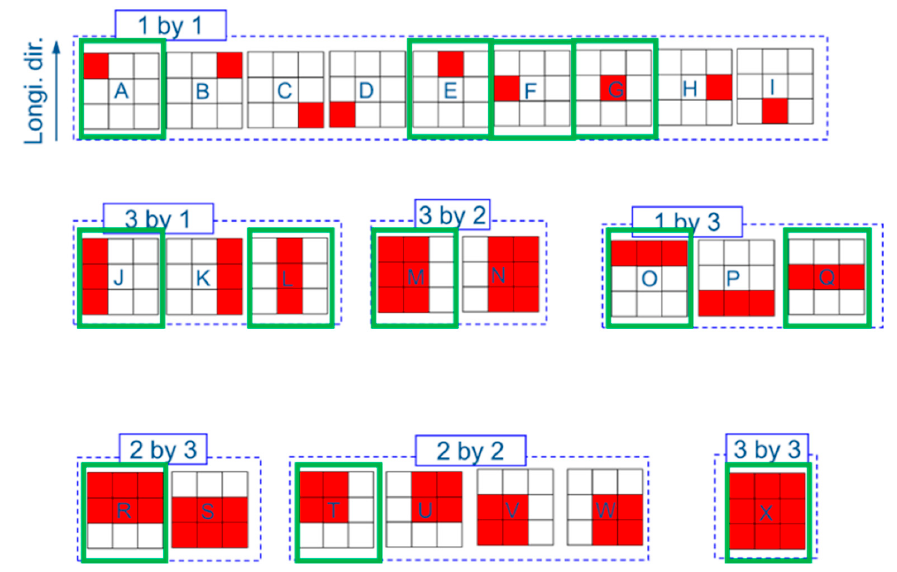
Figure 5. LNG cargo containment system with 12 load cases.